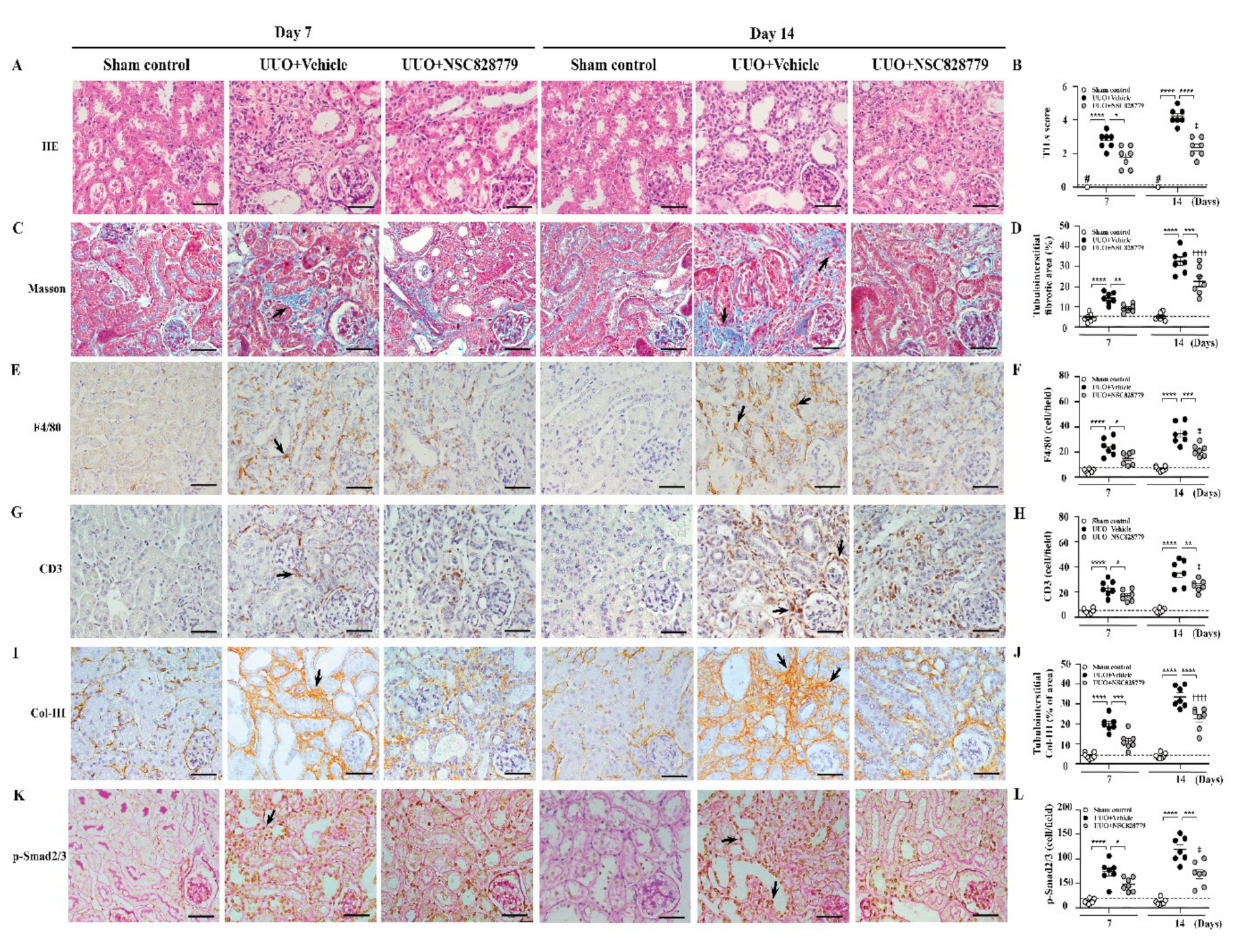
Figure 2. NSC828779 alleviates pathological changes in UUO mice. ( A , B ) H&E staining and scoring. ( C , D ) Masson trichrome staining and scoring of tubulointerstitial fibrotic area. IHC and scoring for F4/80 + ( E , F ), CD3 + ( G , H ), Col-III ( I , J ) and p-Smad2/3 ( K , L ). Original magnification, each 400 × . Data are shown as means ± SEM of seven mice per group. The bar indicates 20 µ m. Arrows indicate positive staining. The horizonal dashed line indicates the mean for sham control + NSC828779. NSC828779, a salicylanilide derivative. UUO, unilateral ureter obstruction; TILs, tubulointerstitial lesions. H&E staining, hematoxylin and eosin stain. Col-III, collagen III. # not detectable. * p < 0.05, ** p < 0.01, *** p < 0.005, **** p < 0.001, †††† p < 0.001 Day 7 versus Day14 of UUO + NSC828779, ‡ no significant difference Day 7 versus Day14 of UUO +